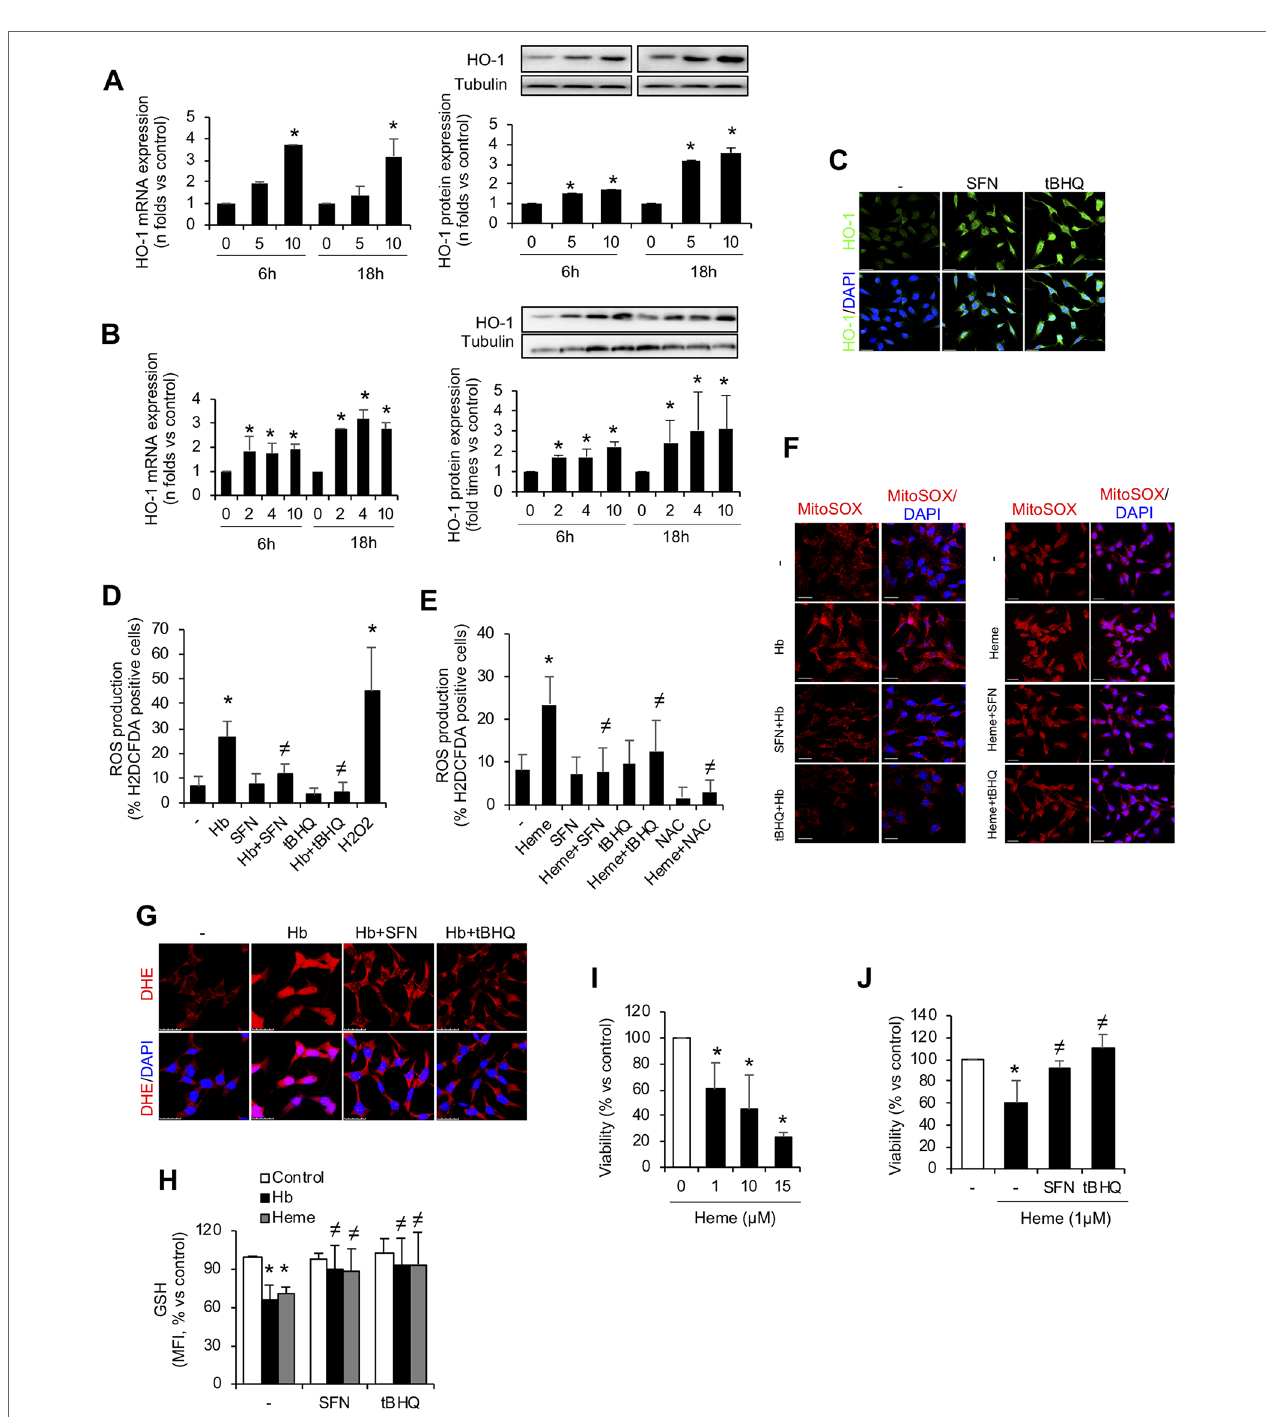
FIGURE 6 | In vitro Nrf2 induction ameliorates oxidative stress and cell death. HO-1 mRNA and protein expression in MCT cells treated with the Nrf2 inducers tert -butylhydroquinone (tBHQ) (A) or sulforaphane (SFN) (B) at different concentrations (µM) for up to 18 h. (C) Representative confocal microscopy images showing HO-1 (green) staining in MCT cells pre-treated with Nrf2 inducers SFN and tBHQ with or without Hb. Nuclei were stained with DAPI (blue); scale bar, 20 μm. Quantification of ROS production (hydrogen peroxide) by flow cytometry with the fluorescent dye H 2 DCFDA in MCT cells stimulated with Hb (D) or heme (E) for 6 h. (F) Representative image of MitoSOX showing mitochondrial superoxide production by Hb (left panel) and heme (right panel) in cells pre-treated with SFN (2 µM) and tBHQ (1 µM) for 16 h. Nuclei were stained with DAPI (blue); scale bar, 20 μm. (G) Representative image of superoxide anion production determined by confocal microscopy using dihydroethidium (DHE) assay. Nuclei were stained with DAPI (blue); scale bar, 20 μm. (H) Intracellular GSH content in MCT cells treated with heme (1 μM) for 6 h with or without SFN (2 μM) or tBHQ (1 µM). (I–J) Cell viability determined in MCT cells stimulated with heme (1 μM) for 24 h and pre-treated with SFN (2 μM) or tBHQ (1 µM). Results are expressed as mean ± SEM. * p < 0.05 vs non-treated cells. ≠ p < 0.05 vs Hb or heme-treated